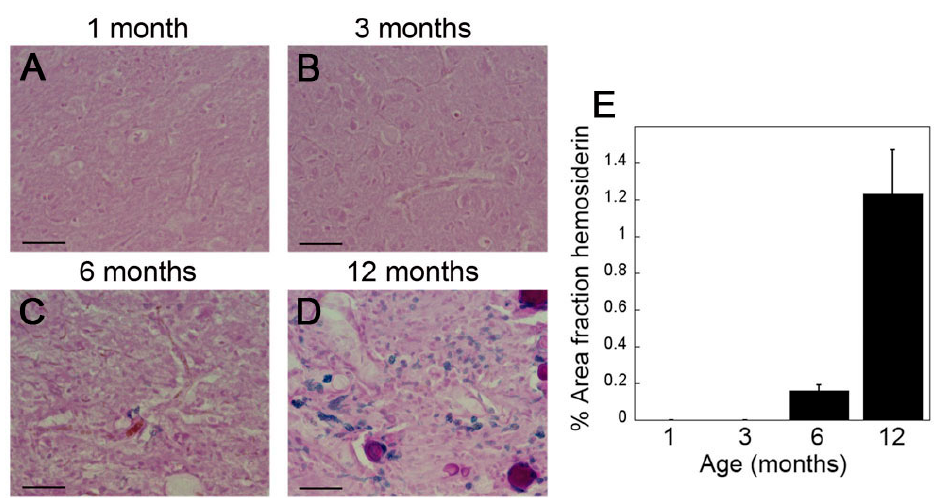
Figure 4. Emergence of cerebral microbleeds in rTg-DI rats. Representative brain sections showing the thalamic region from rTg-DI rats aged to one month ( A ), three months ( B ), six months ( C ) and twelve months ( D ) that were stained for hemosiderin to identify microhemorrhages (blue). Scale bars = 50 µ m. ( E ) The percent area fraction of hemosiderin staining was quantitated in the thalamus of 1, 3, 6, and 12 months old rTg-DI rats. Data represent the mean ± S.D. of 6–7 rTg-DI rats per group.